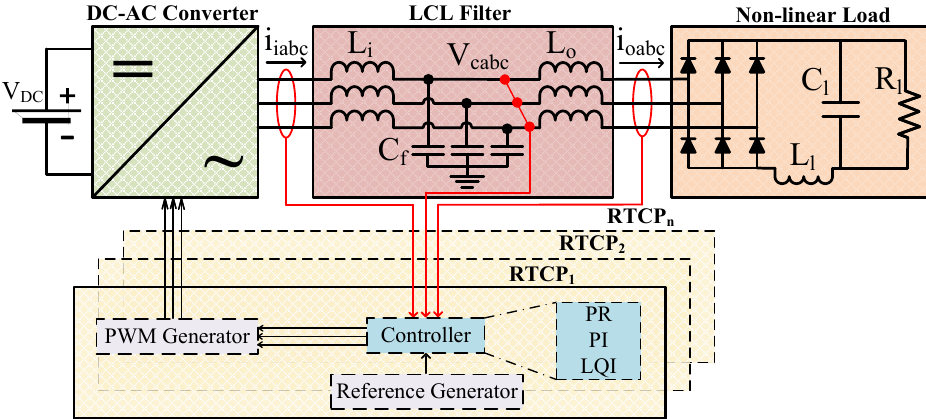
Figure 4. General structure of the control of a DC/AC SPC connected to a non-linear load.